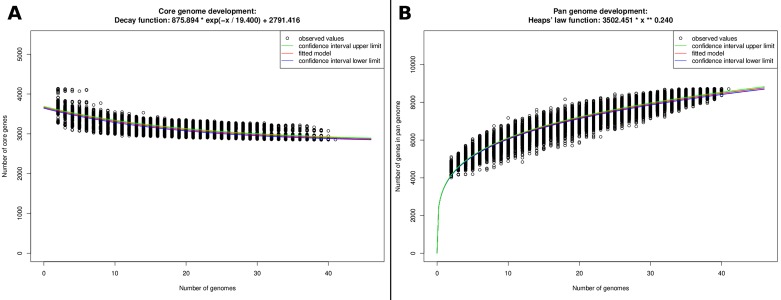
Pan vs. core genome development plot for A. veronii genomes.